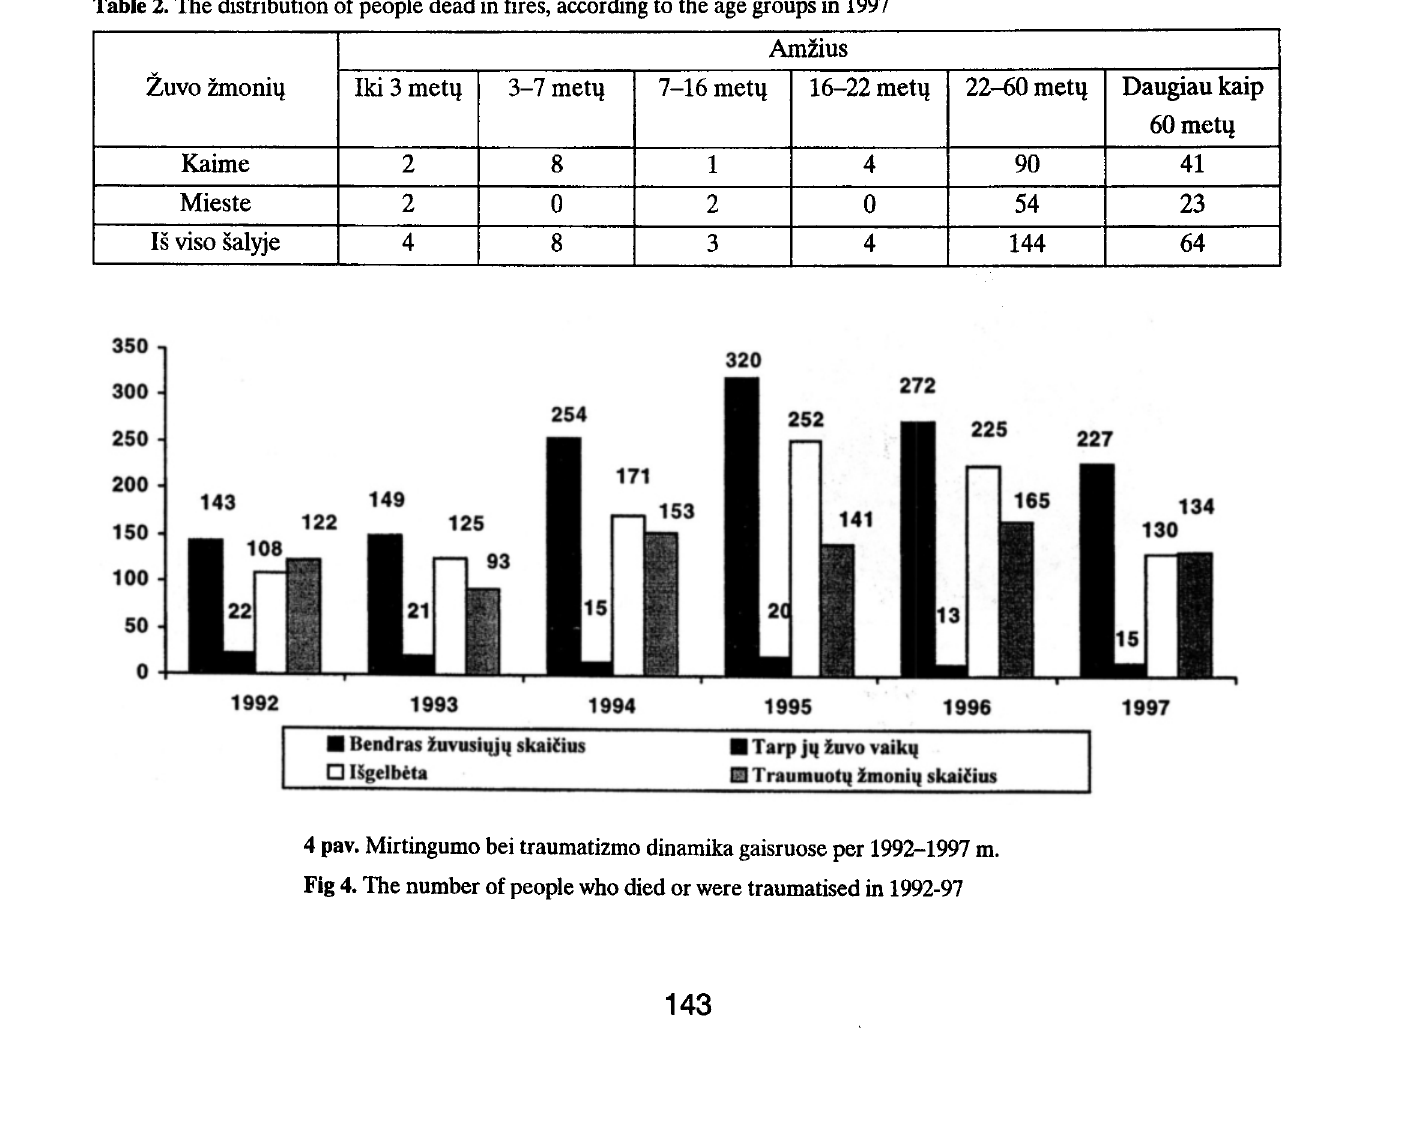
3 pav. Gaisrq priezastys 1997 m. Fig 3. The reasons of fires in 1997